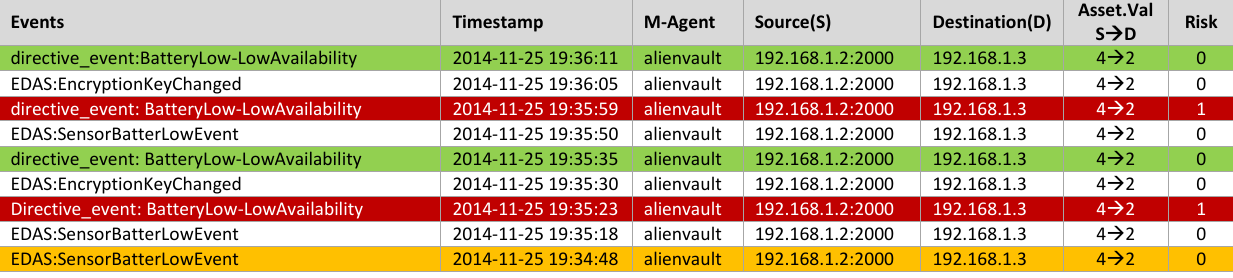
Figure 15. Scenario 1: EDAS platform dashboard screen (modified): the LowAvailability alarm is raised (as risk = 1) whenever a BatteryLow event is detected and is reduced when a KeyChanged event is observed after adaptation. Color legend: yellow, trigger event; red, alarm (unacceptable risk); green, alarm (acceptable risk); white, event detected